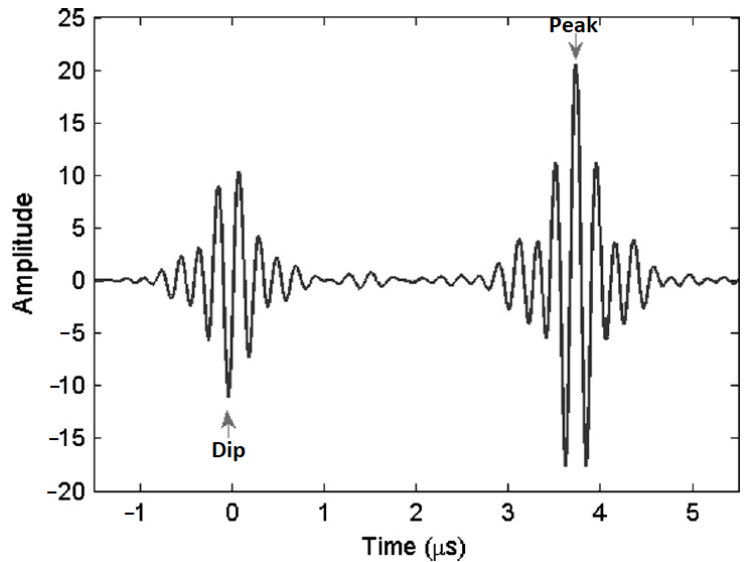
Figure 10. The dip and peak of pulses attributed to the front pipe wall and back pipe wall (designated by the arrows) which are 180 ◦ apart in phase. Reprinted from Ultrasonics, Volume 53, Honarvar, F.; Salehi, F.; Sasfavi, V.; Mokhtari, A.; Sinclair, A.N. Ultrasonic Monitoring of Erosion/Corrosion Thinning Rates in Industrial Piping Systems, Page 1251–1258, Year 2013 with permission from Elsevier